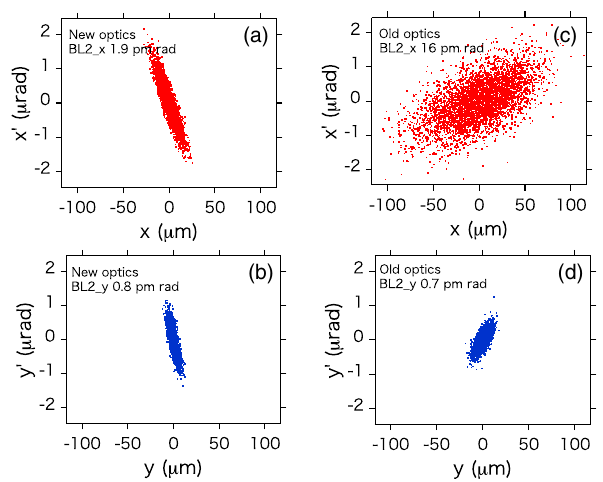
FIG. 6. Stability of the electron beam orbit after the BL2 dogleg measured with (a, b) the new beam optics and (c, d) the old beam optics. The beam energy and peak current of the electron bunches are 7.9 GeV and about 10 kA.